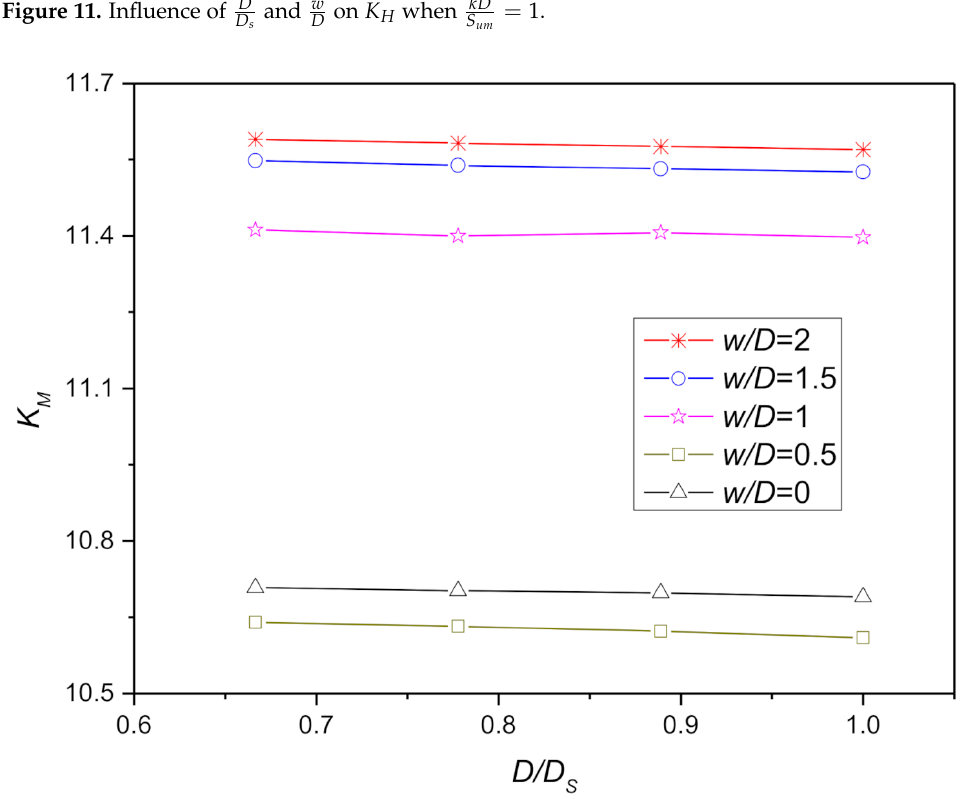
Figure 11. Influence of D